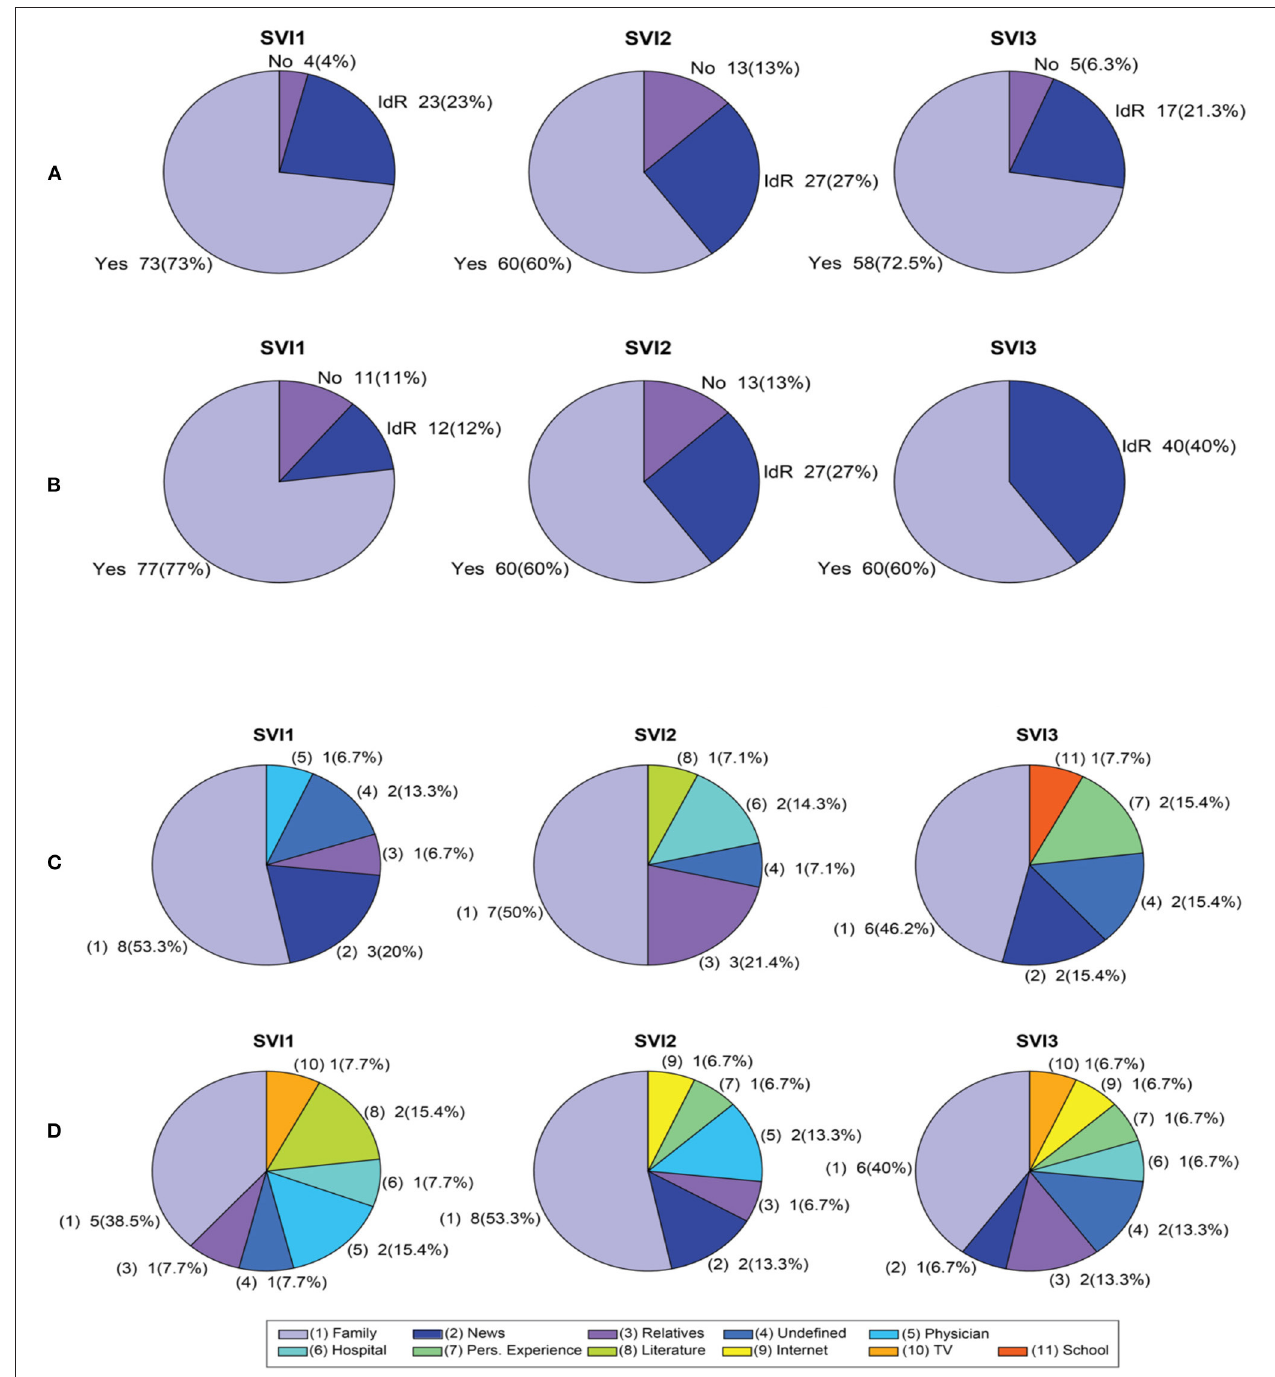
FIGURE 1 | Distribution of responses (in %) according to SVI, Question 2: Have you heard about pneumonia? (Part 1), (A) 8th and (B) 9th. Frequency distribution of responses by SVI according to source of information Question 2: How did you know? (Part 2), (C) 8th and (D) 9th. *Zero values were excluded in the construction of the (C,D)